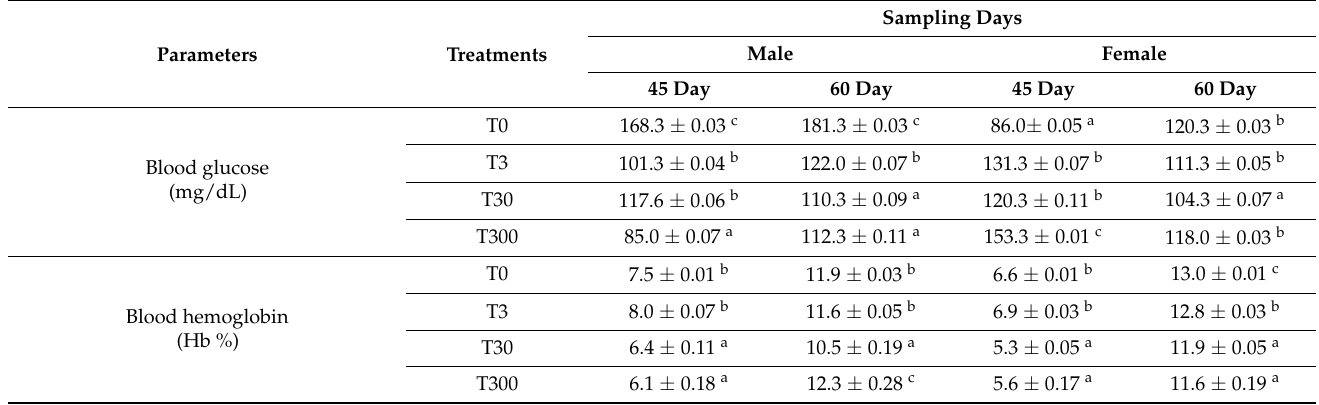
Table 4. Changes in hemato-biochemical parameters of climbing perch exposed to different concen- trations of ethinylestradiol/desogestrel